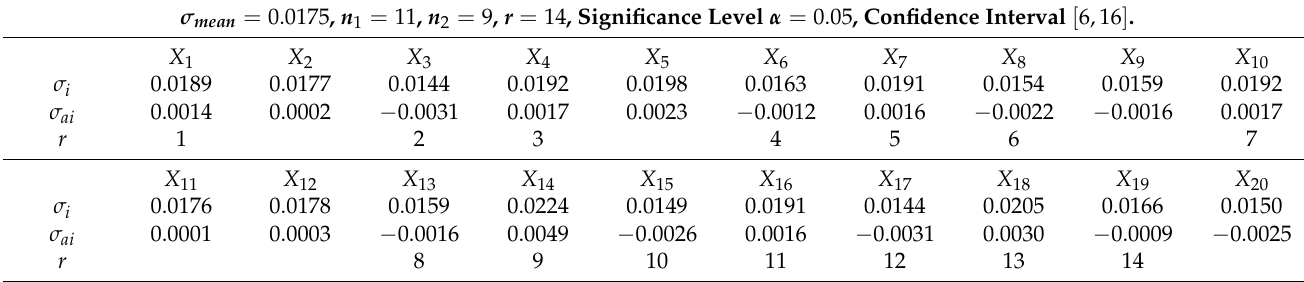
Table 2. Run test process of x -axis BiLSTM network results.